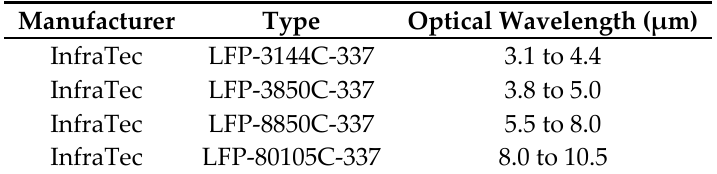
Table 1. List of sensors which has been used in Warwick Optical E-Nose.